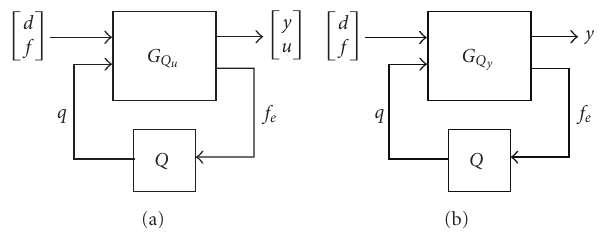
Figure 4: LFT formulations for compensator Q: (a) Control signal and output attenuation, and (b) output signal